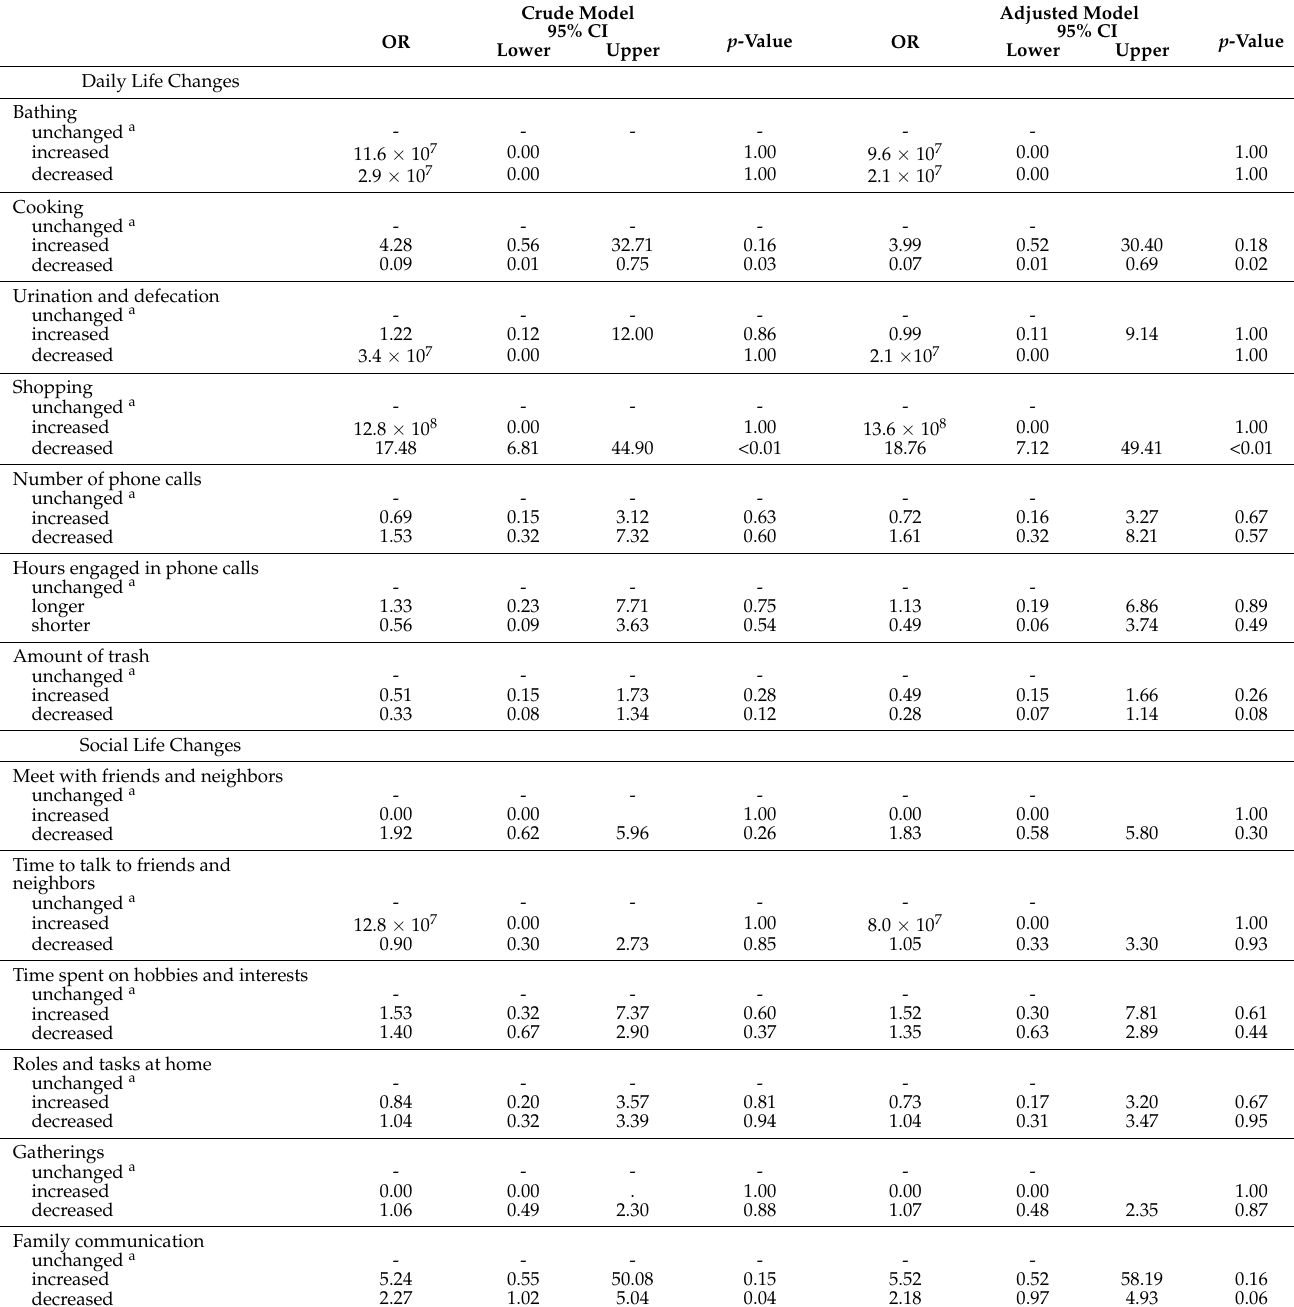
FOS according to the crude model. After adjusting for potential covariates, the decreased frequencies of cooking meals (OR: 0.07, 95% CI: 0.01–0.69; p = 0.02), shopping (OR: 18.76; 95% CI: 7.12–49.41; p < 0.01), and eating out (OR: 3.47; 95% CI: 1.21–9.97; p = 0.02) were significantly related to the FOS according to the adjusted model. Table 5. Association between frequency of socialization and daily life, social life, and physical function. Crude Model Adjusted Model 95% CI p -Value 95% CI p -Value OR OR Lower Upper Lower